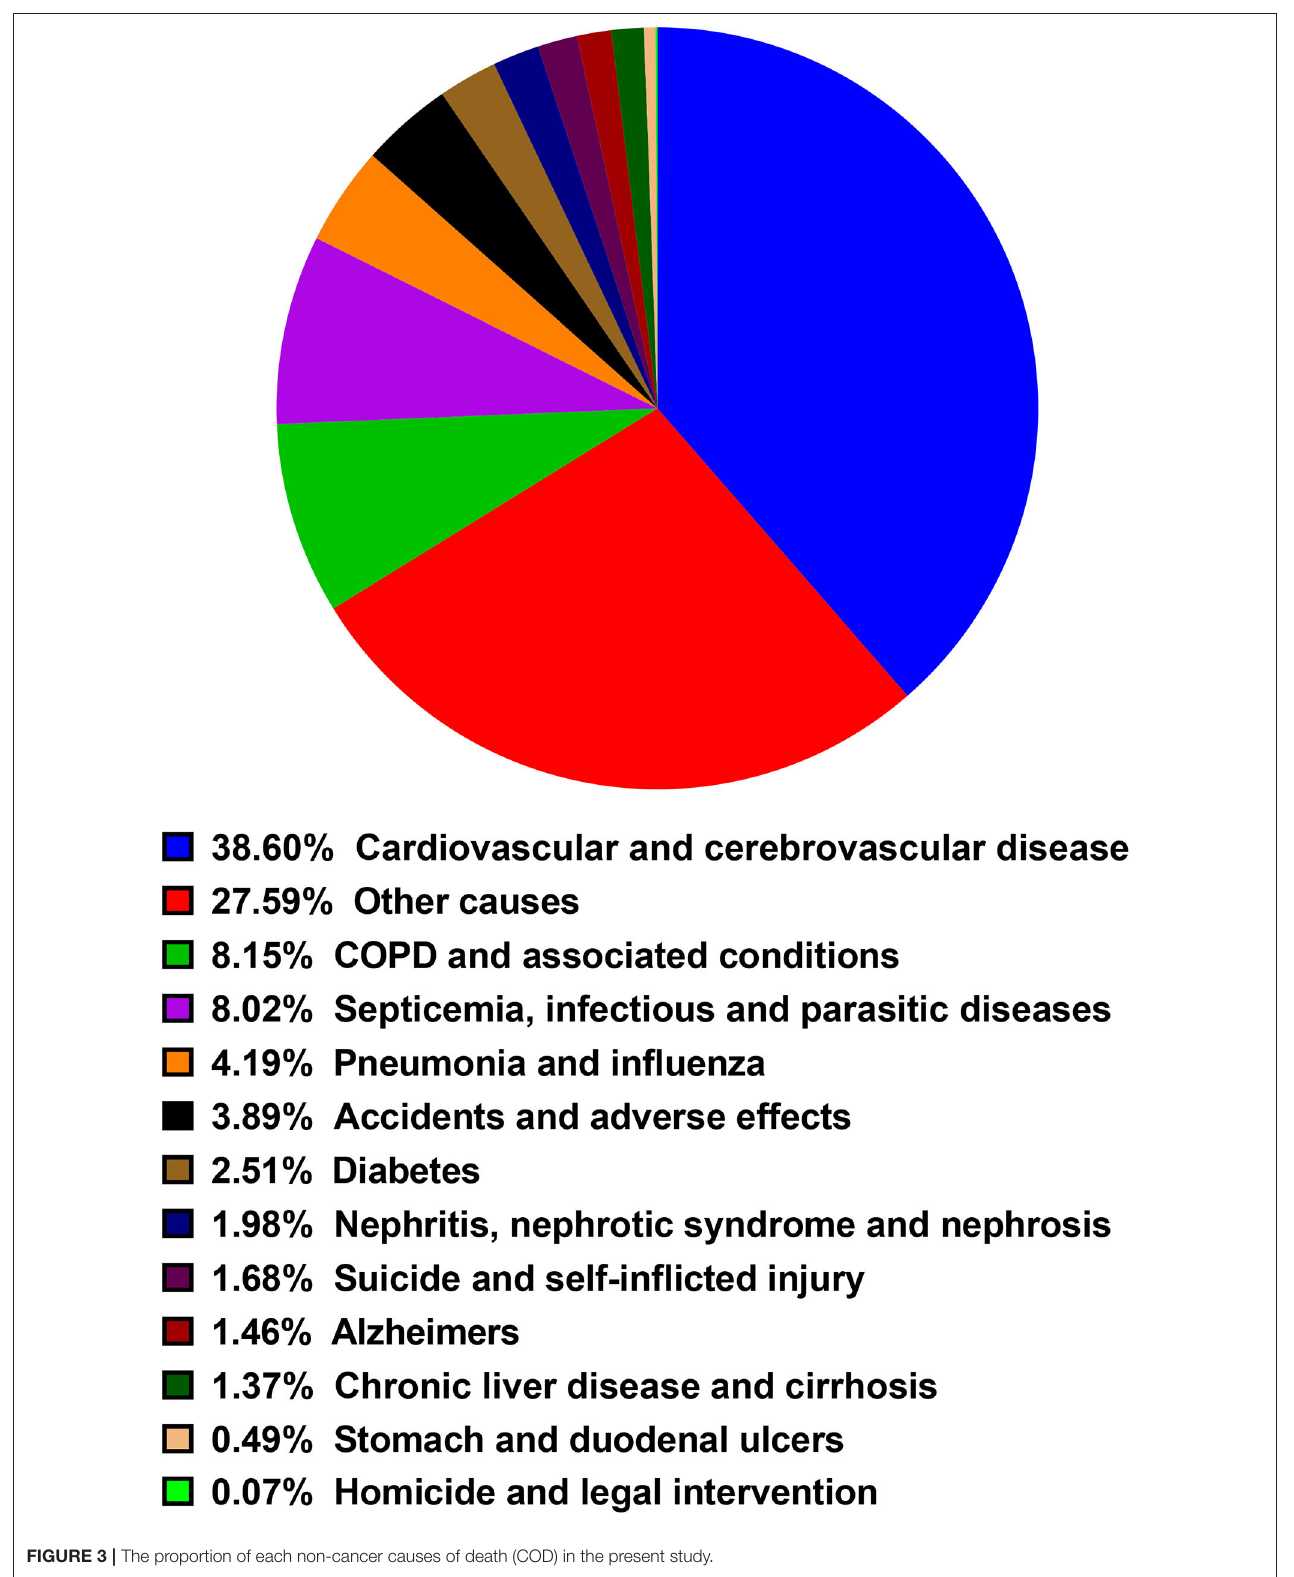
FIGURE 3 | The proportion of each non-cancer causes of death (COD) in the present study.